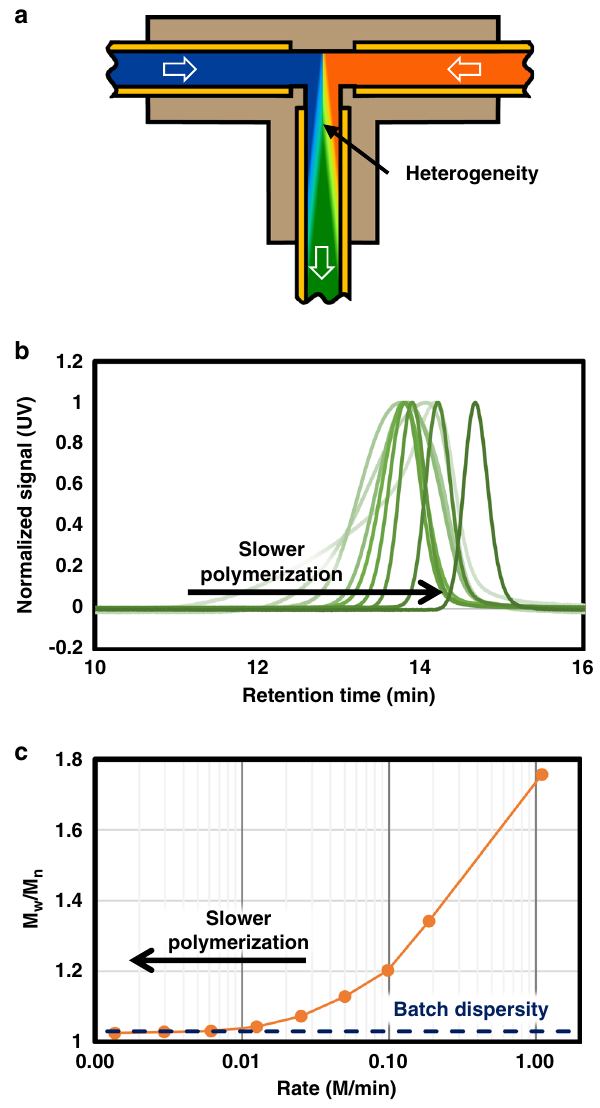
Fig. 5 Diagram and experimental data for polymerization mixing experiments. a Representation of the heterogeneity of the fl uid at the entrance of the tubular reactor. b GPC traces for mixing experiment. c Dependancy of polymer dispersity on the rate of